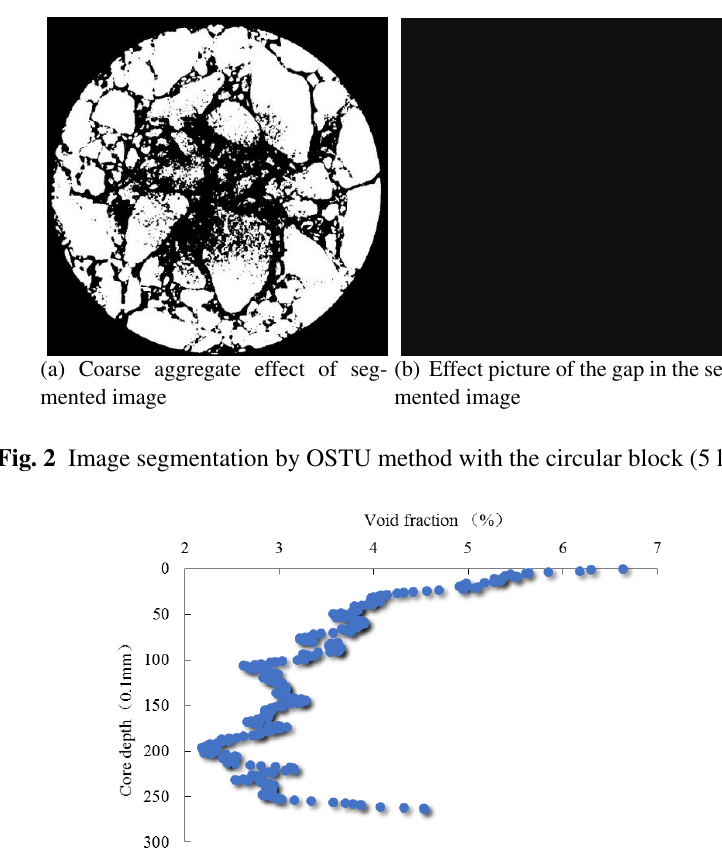
Fig. 3 Void fraction distribution of pavement core